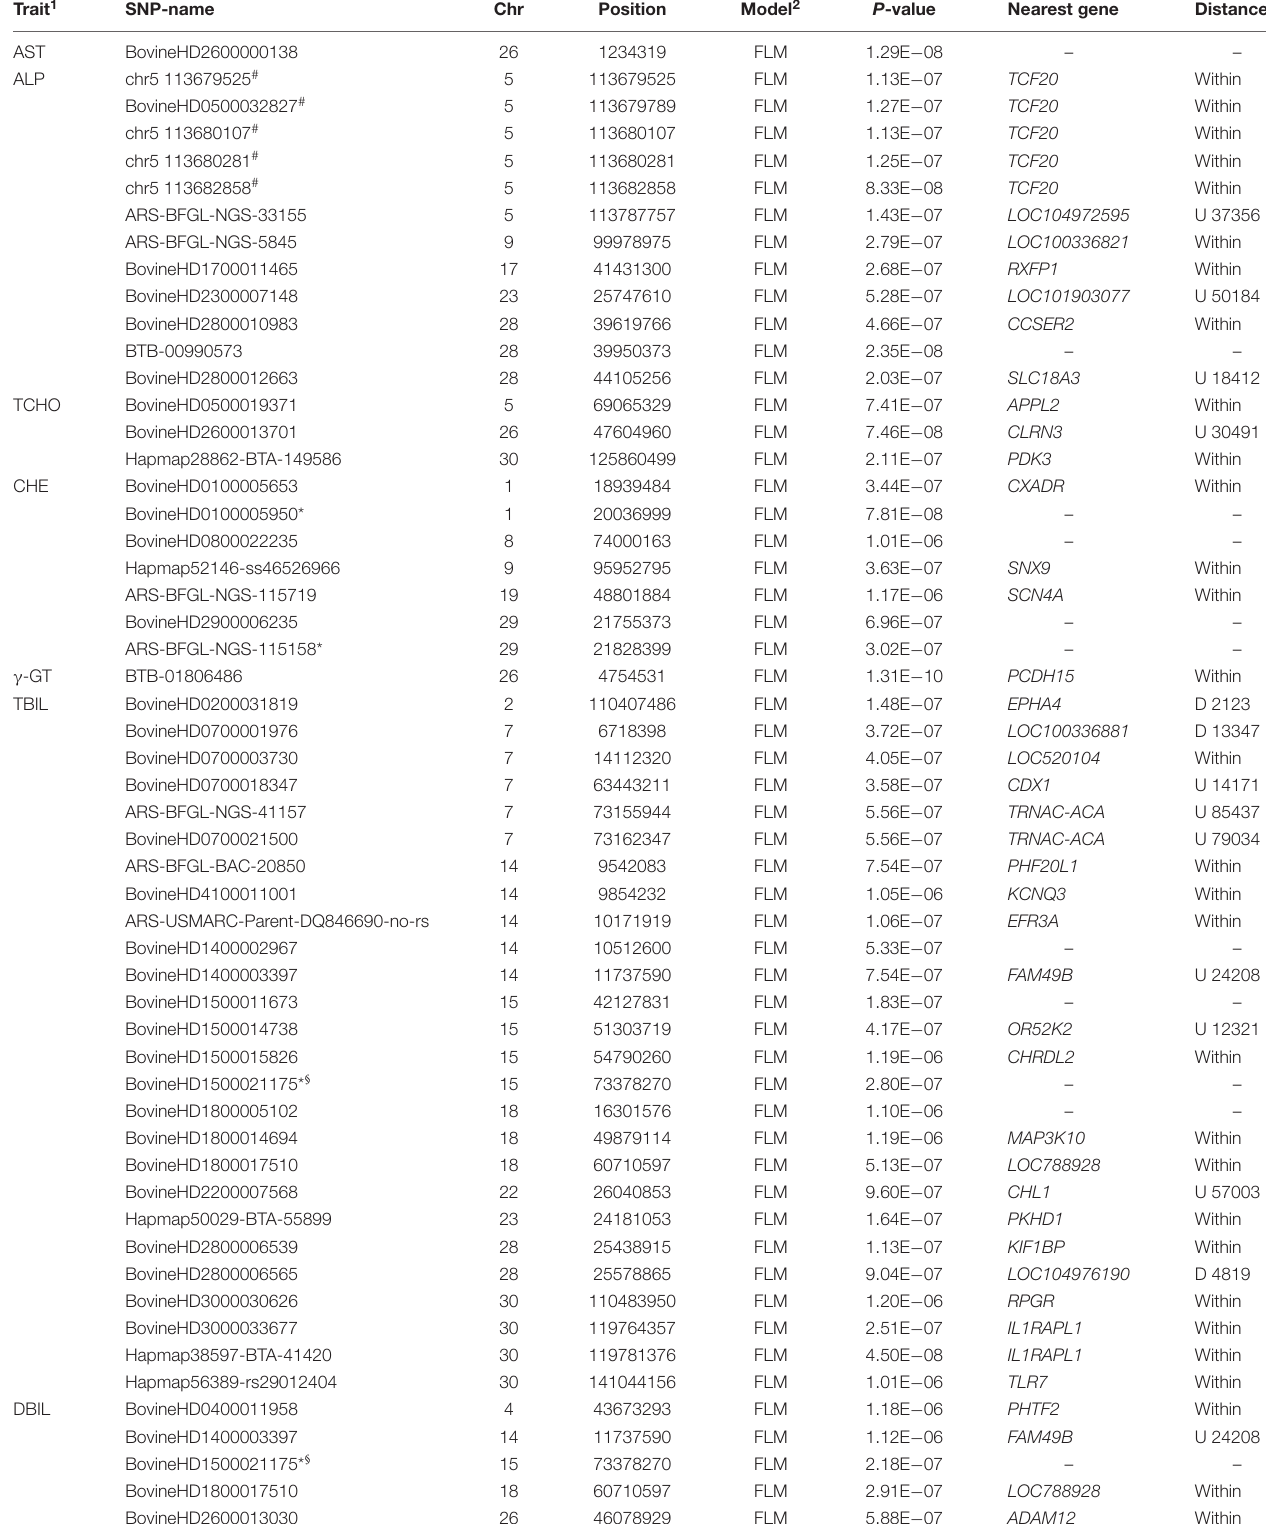
TABLE 1 | Genome-wide significant SNPs that were identified to be associated with serum indexes in Chinese Holstein cattle using a fixed linear